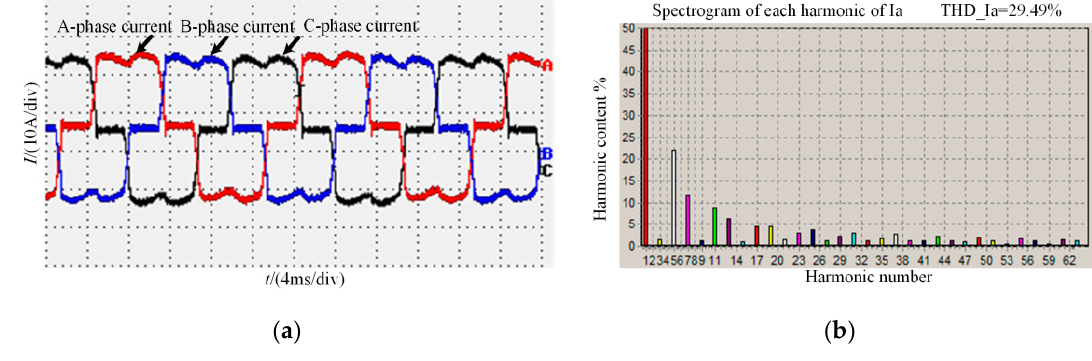
Figure 16. Before compensation: ( a ) Grid current; ( b ) Current THD.